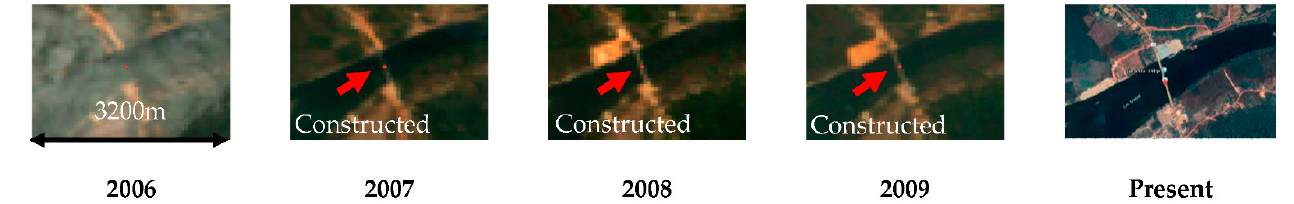
Figure 4. Yearly Landsat images of the Sre Ambel (L = 420 m) bridge. The appearance of the bridge in the 2007 image indicates that the year of construction was 2007.